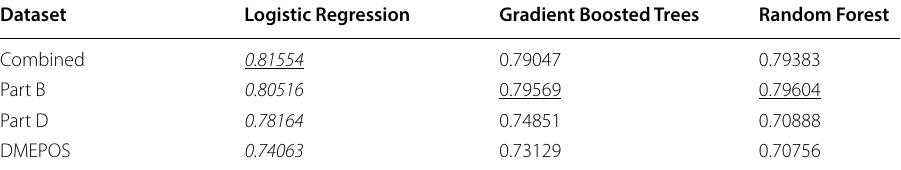
Table 11 Learner AUC results by